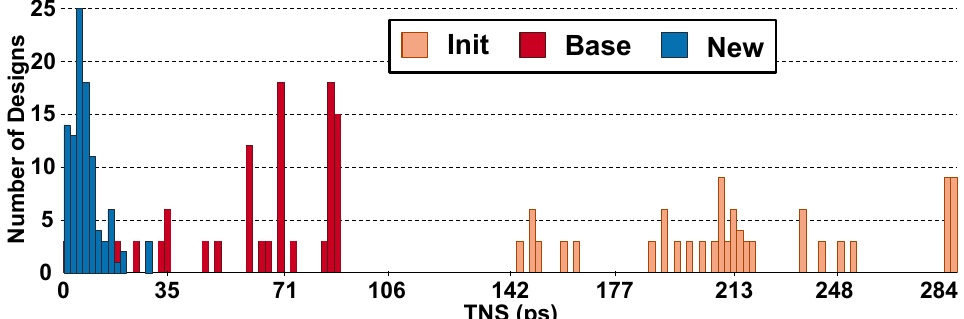
Figure 9. Histogram of late TNS initially (Init) and at end of LR-based gate sizing without (Base) and with (New) proposed LM initialization. Histograms correspond to 100 versions of fft_fast with randomly perturbed RC characteristics.